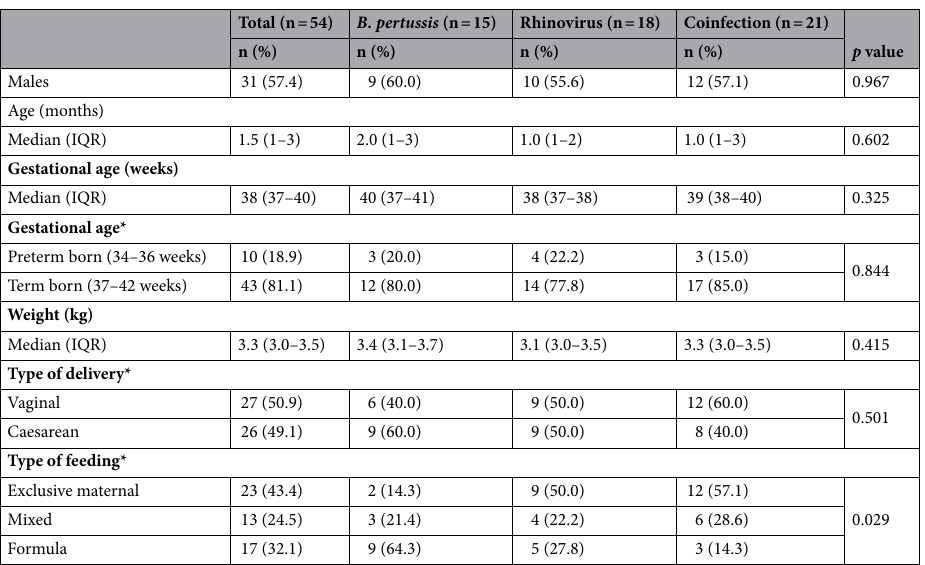
Table 1. Characteristics of the patients (n = 54). *missing values for 1